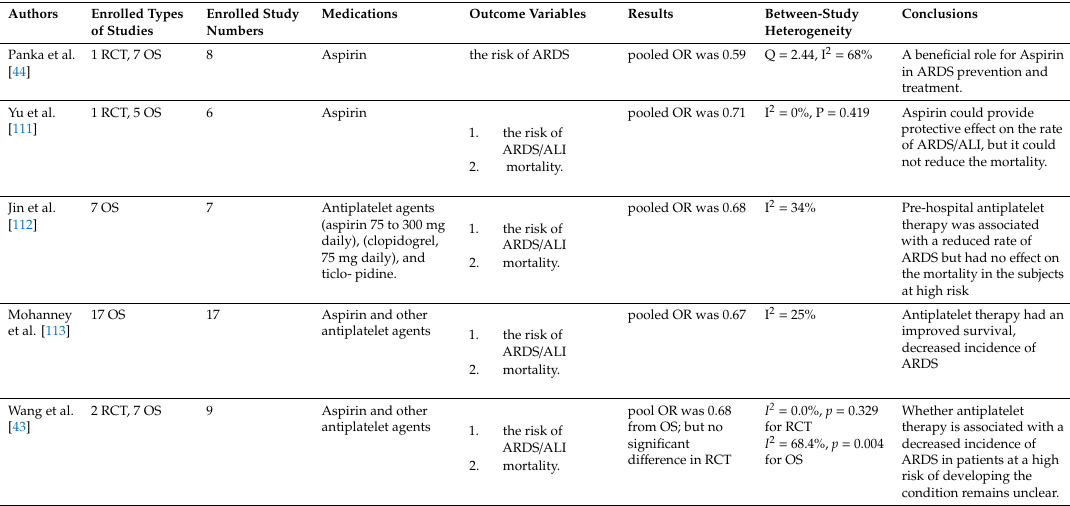
Table 2. Summary of meta-analysis of the e ff ect of aspirin on